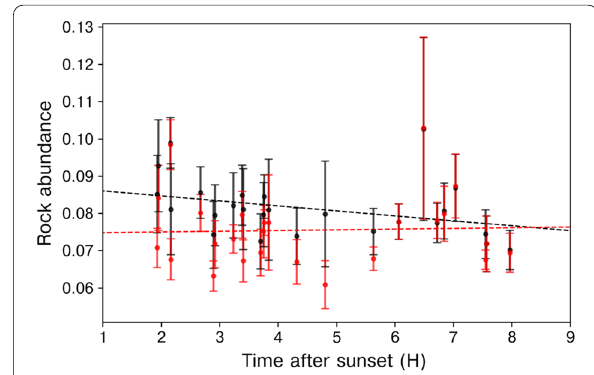
Fig. 11 The rock abundance at Tycho crater and its relationship with local time after sunset. The black and red points show estimates based on the assumption of H of 7 cm and best-fit regolith temperatures. The black and red dashed lines are linear regressions for both cases with correlation coefficients of -0.34 and 0.04, respectively. Each error bar corresponds to a standard deviation of rock abundance estimated in all the analyzed AHI